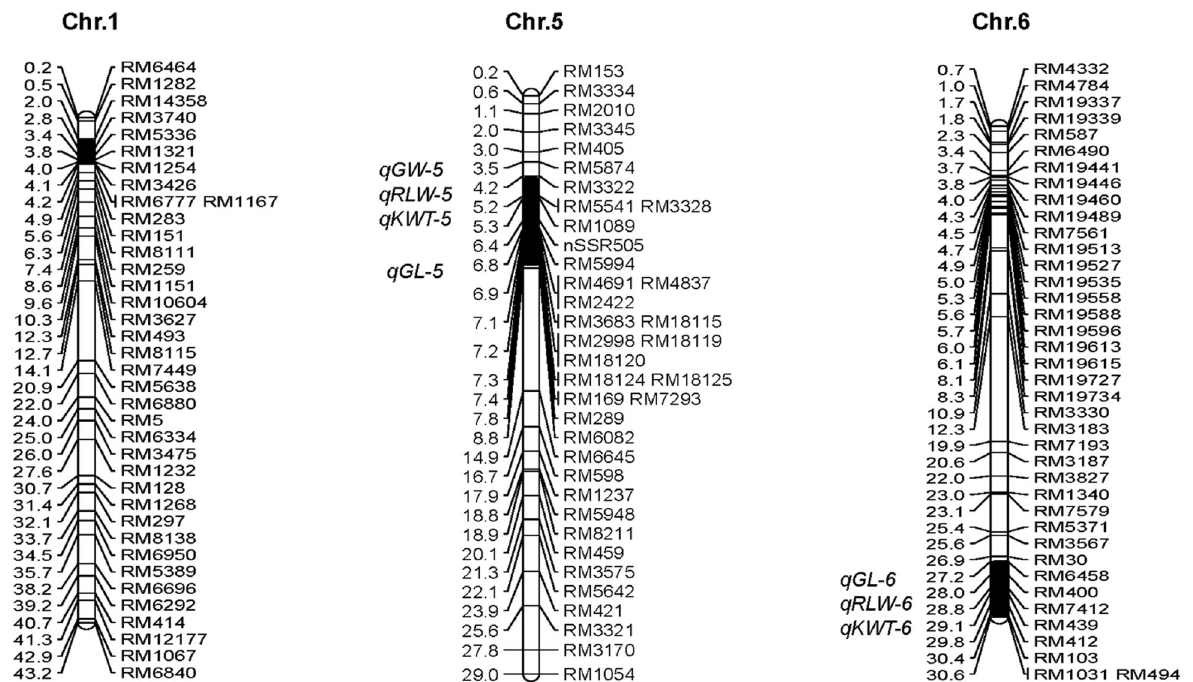
Fig. 1 Substitution segments harbored in the CSSL Z1392 and position of grain size related QTLs. Physical distance (Mb) is specified on the left of each chromosome (based on the Nipponbare reference genome) and markers are specified on the right. The solid black segment is the substitution fragment region from the donor Xihui 18 and the identified QTLs are listed on the left of each chromosome in italics. qGL , QTL for grain length; qGW , QTL for grain width; qRLW , QTL for ratio of length to width; qKWT , QTL for 1000-grain